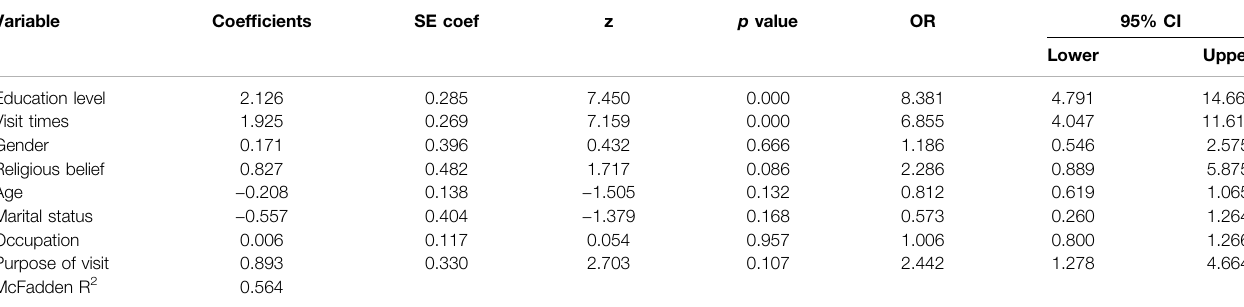
TABLE 3 | Factors affecting respondents ’ temple air pollution policy measures